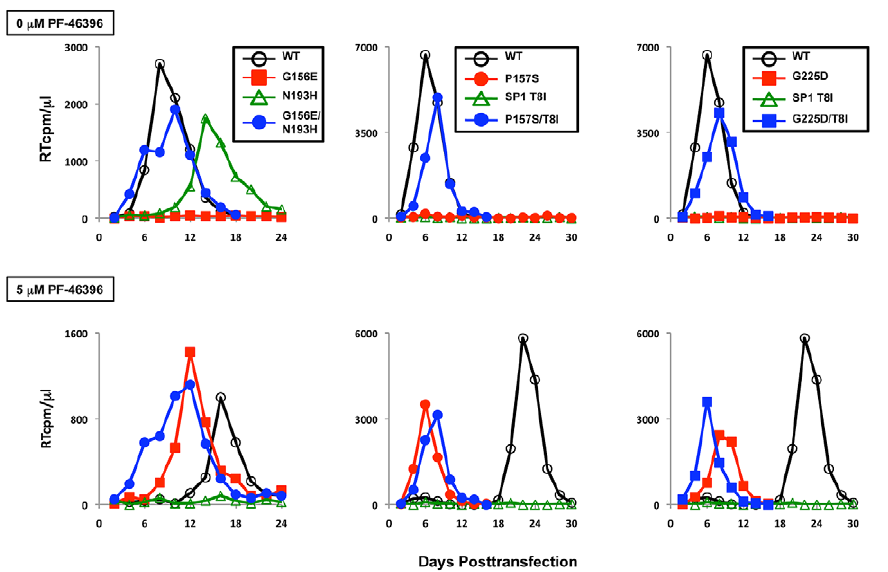
Figure 11. Virus replication kinetics in the absence (top) and presence (bottom) of PF-46396. The Jurkat T-cell line was transfected with WT or mutant pNL4-3 and propagated in the presence of 0 or 5 m M PF-46396. Virus replication was monitored by RT activity, shown in cpm/ m l.